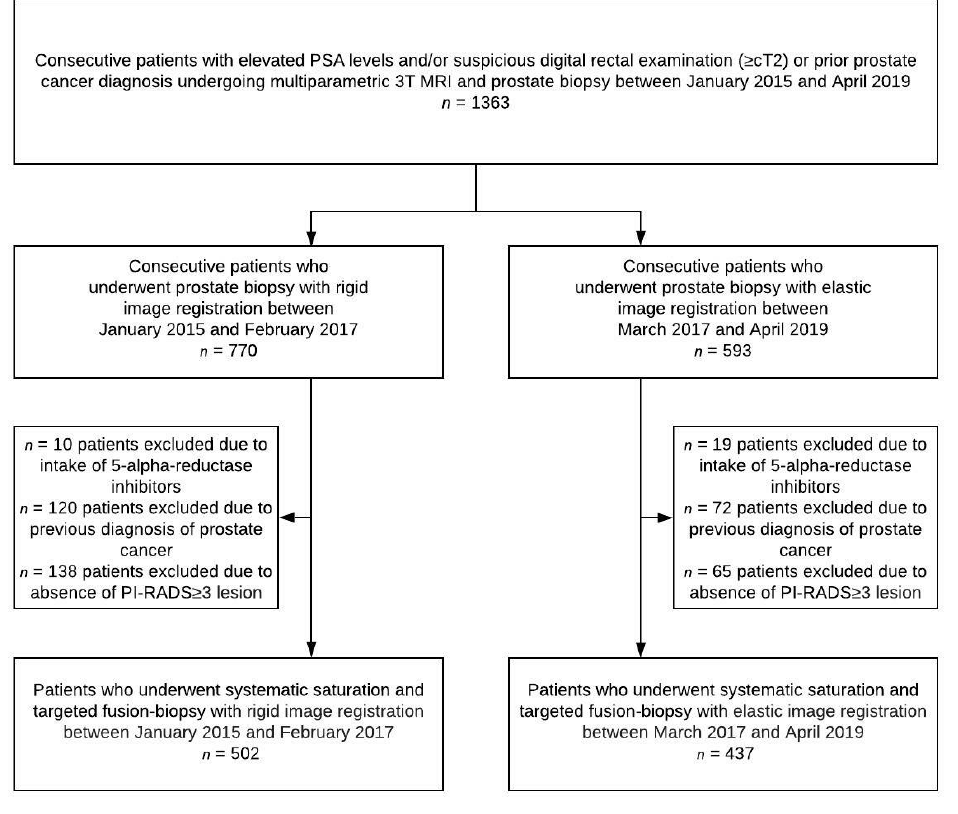
Figure 1. Flow chart for subgroups. MRI = magnetic resonance imaging; PI-RADS = Prostate Imaging-Reporting and Data System; PSA = prostate specific antigen.